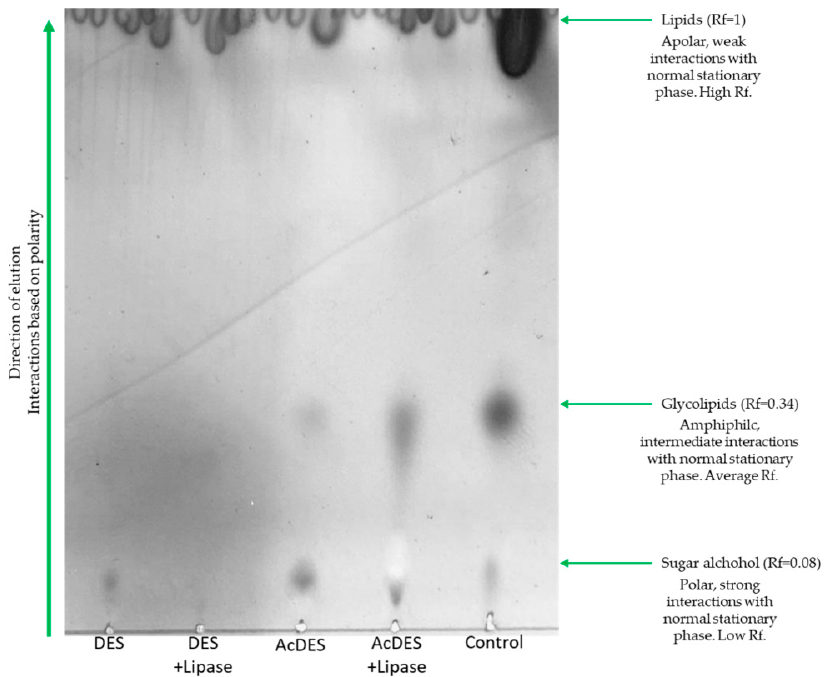
Figure 3. Thin layer chromatography of the reactions processed with microwave irradiation including a control using directly Fatty Acid Methyl Esters (FAMEs) from yeast biomass. AcDES: acidified DES; DES: standard DES.